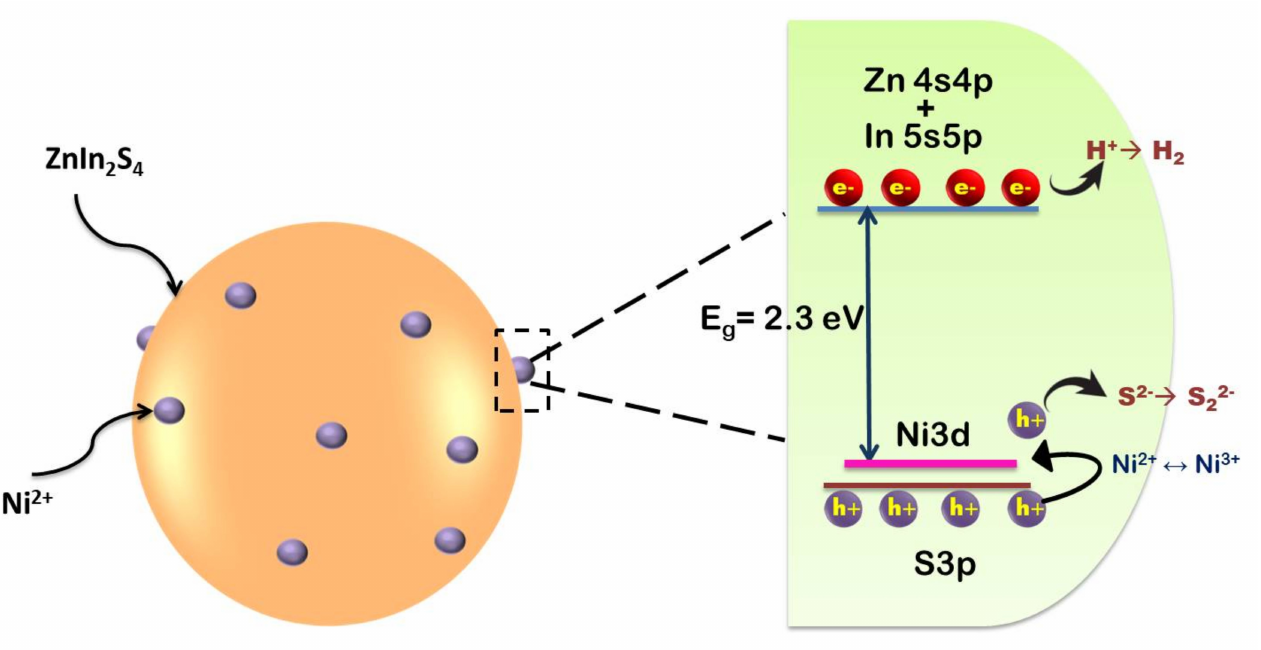
Figure 4. Schematic for band structure of Ni 2+ doped ZnIn 2 S 4 . Figure adapted from